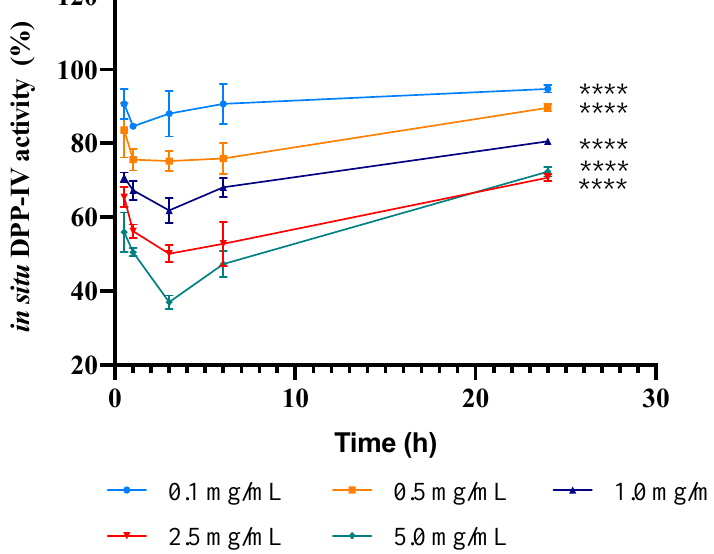
Figure 3. The kinetics of the inhibition of in situ DPP-IV activity after incubating Caco-2 cells with the PBP hydrolysate at different concentrations. The data are represented as the means ± SD of six independent experiments, performed in triplicate. Multiple comparisons by two-way ANOVA were performed, comparing within each concentration, each time point, and comparing within each time point, each concentration. (****) p < 0.0001.